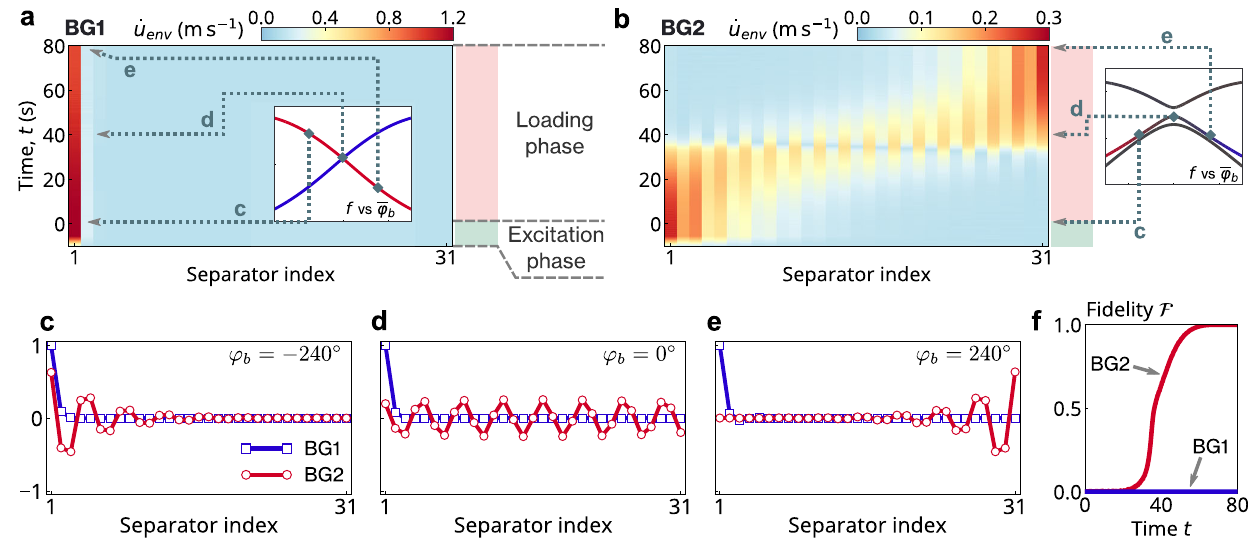
Fig. 5 Numerical calculation of the topological state transfer through the dimer Kresling lattice. Axial velocity envelope fi elds _ u env ð t Þ for the case of a BG1 and b BG2. Unit is m s − 1 . The fi rst 10 s ( t ∈ [ − 10, 0] s) of the numerical solution is the excitation phase at 147.8 and 200.4 Hz, respectively. Within t ∈ [0, 80] s (therefore T = 80 s), the lattice is quasi-statically twisted in φ ∈ [ − 240°, 240°]. The subplots schematically illustrate the transition of b excited eigenmodes as a function of twist angle (similar to Fig. 3b, c, but with 32 unit cells). Grey arrows point toward the corresponding instances in the numerical simulations. The extracted normal modes of the axial velocity pro fi les during the quasi-static loading phase are plotted for c − 240°, d 0°, and e 240°. f The time evolution of the fi delity F de fi ned by Eq. (10). In c – f , blue solid lines, BG1; red solid lines,